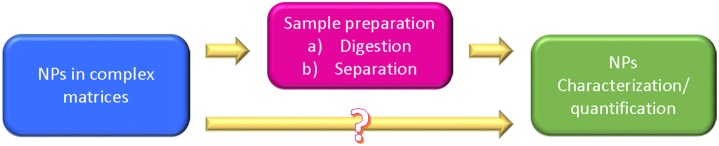
Possible experimental strategies for analyzing NPs in complex matrices.